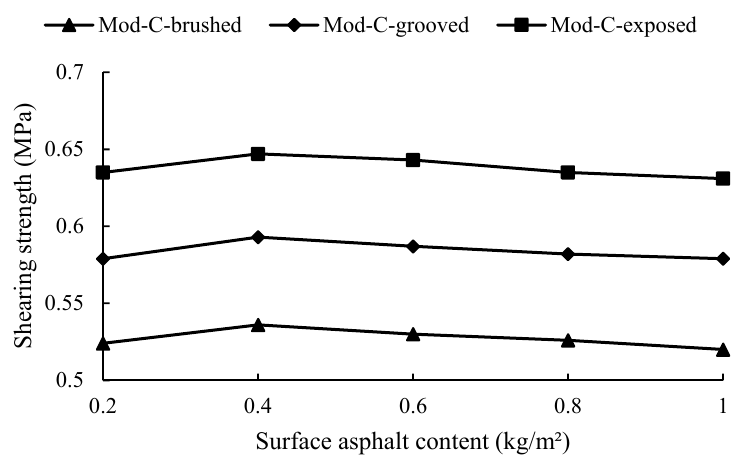
Figure 7. Shear strength of SBS-modified asphalt under different upper layer asphalt content.